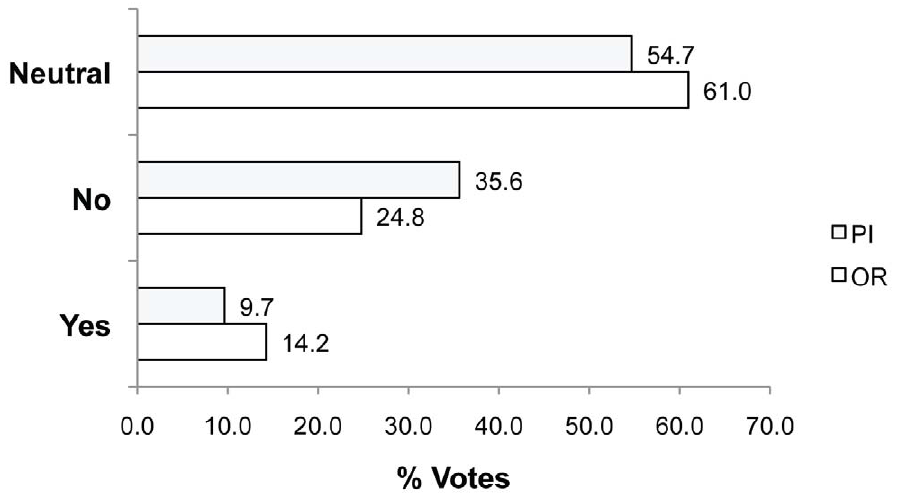
Figure 6. Percent of Yes, No and Neutral votes in response to Q4. Question 4: In procedures resulting in painful outcomes for the animals, should pain relief always be provided?